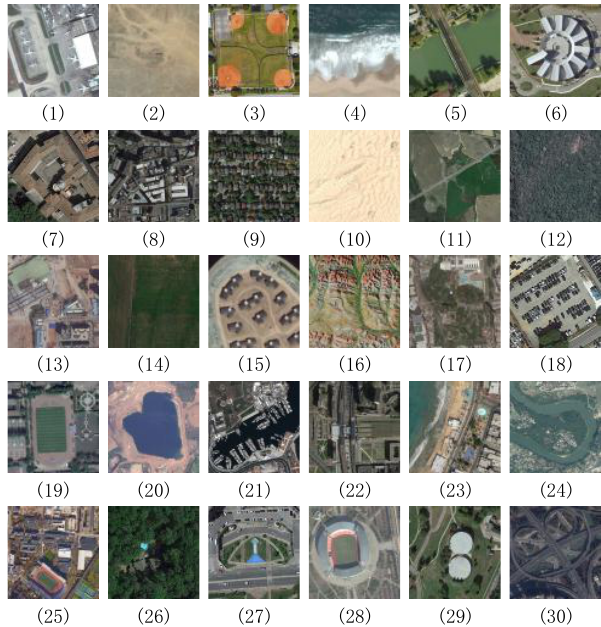
Figure 9. Class representatives of the Aerial Image Dataset (AID) dataset: (1) Airport; (2) Bare land; (3) Baseball field; (4) Beach; (5) Bridge; (6) Center; (7) Church; (8) Commercial; (9) Dense residential; (10) Desert; (11) Farmland; (12) Forest; (13) Industrial; (14) Meadow; (15) Medium residential; (16) Mountain; (17) Park; (18) Parking; (19) Playground; (20) Pond; (21) Port; (22) Railway station; (23) Resort; (24) River; (25) School; (26) Sparse residential; (27) Square; (28) Stadium; (29) Storage